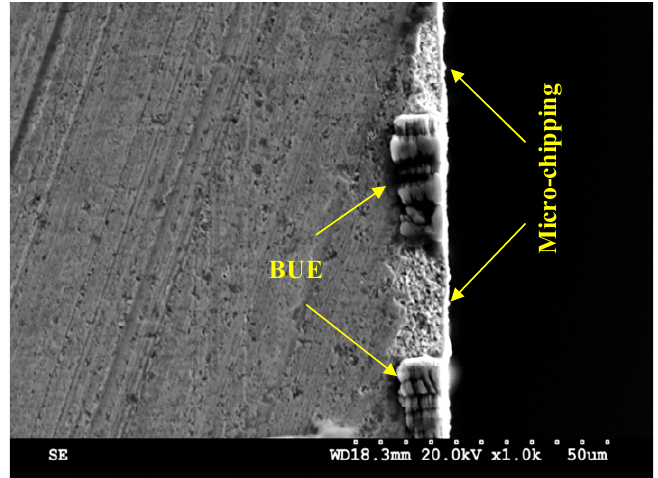
Figure 14. SEM image of the cutting insert for f = 0.25 mm/rev and V = 300 m/min.